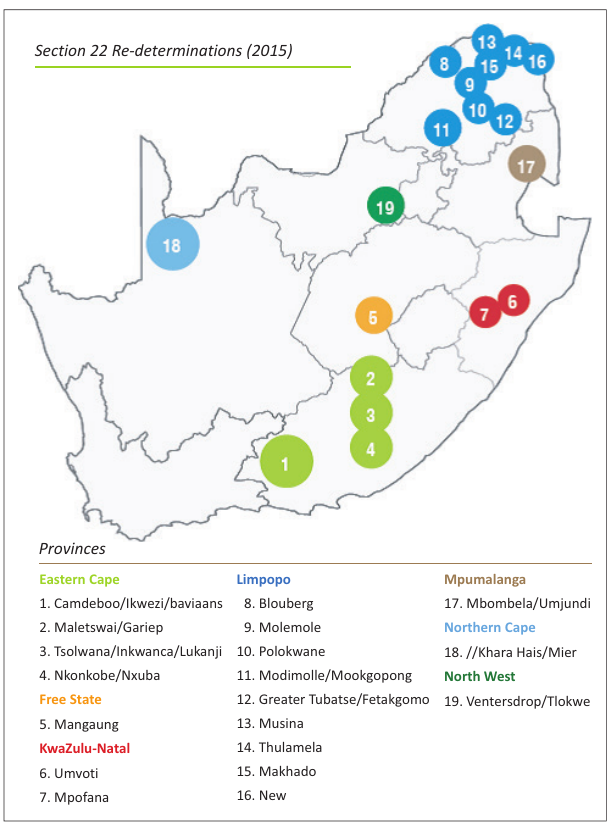
FIGURE 1: Final reconfiguration of municipal boundaries in